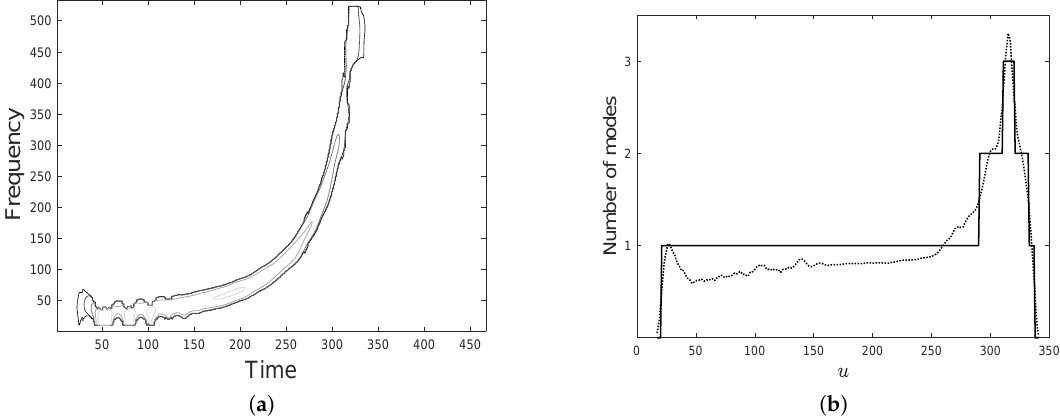
Figure 21. ( a ) Thresholded spectrogram in Figure 20b by using the optimal values in Figure 20c. ( b ) Estimated number of modes by applying the Rényi entropy-based method to ( a ). Local Rényi entropy (dotted line) and its rounded value (solid